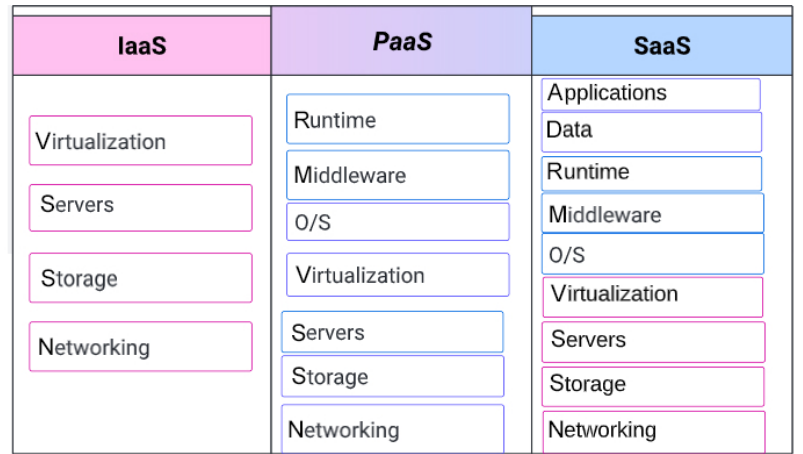
Fig. 1 Cloud computing